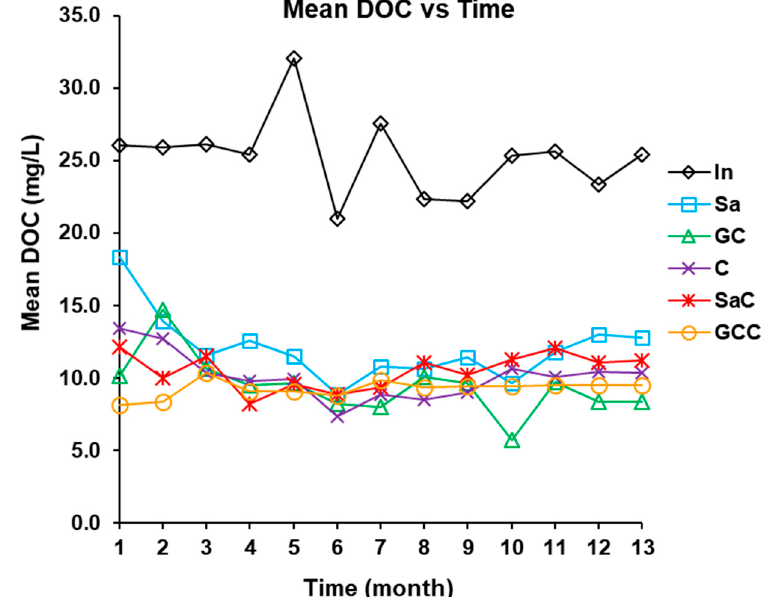
Figure 4. Dissolved organic carbon (DOC) variation during the entire study period (Sa, sand; GC, gas concrete; C, biochar; SaC, sand + biochar; GCC = gas concrete + biochar).